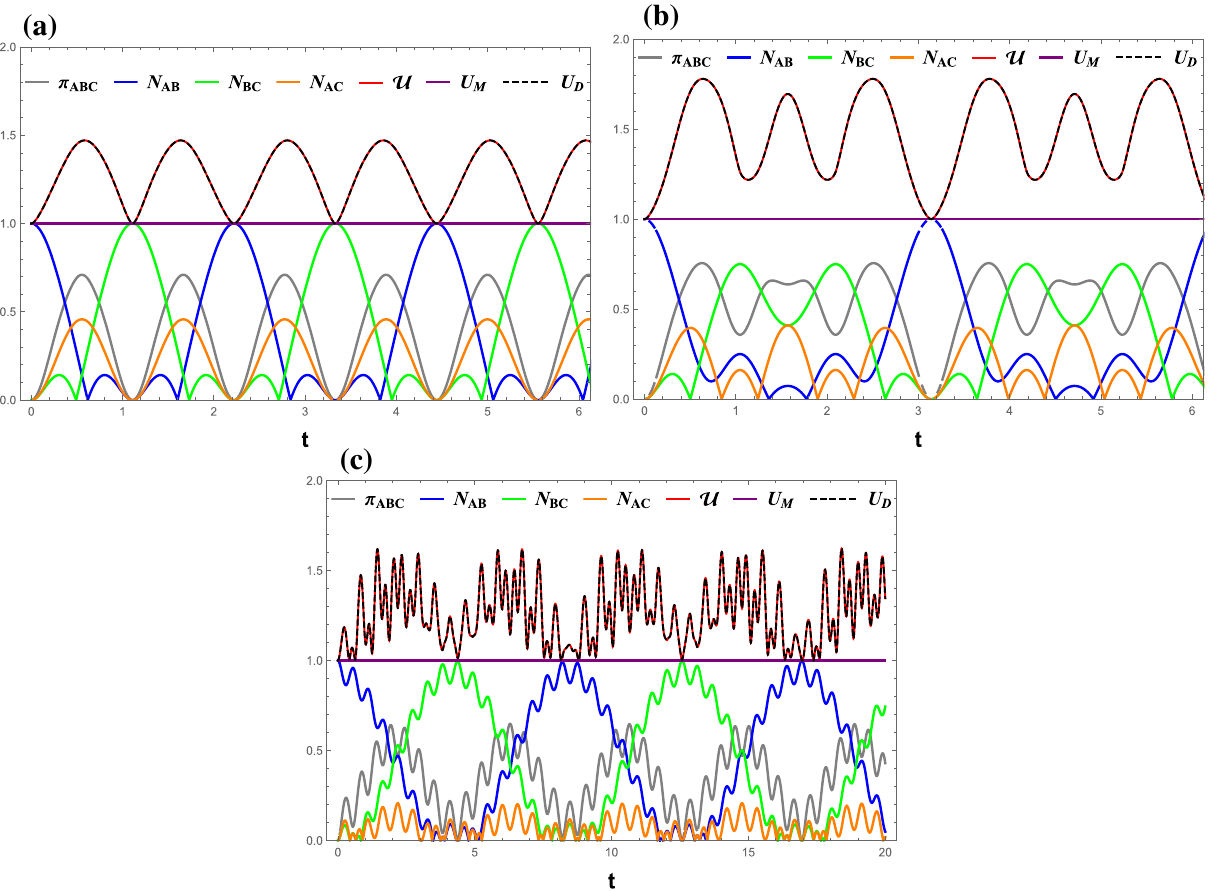
Figure 1. (Color online) Time evolutions of U (red line), U M (purple line), U D (black dashed), π ABC (gray line), N AB (blue line), N BC (green line), and N AC (orange line) under the measurement ( σ x , σ z ). ( a ) J z = 0, ( b ) J z = 1, and ( c ) J z = 5. All Figs. γ = 0, B =